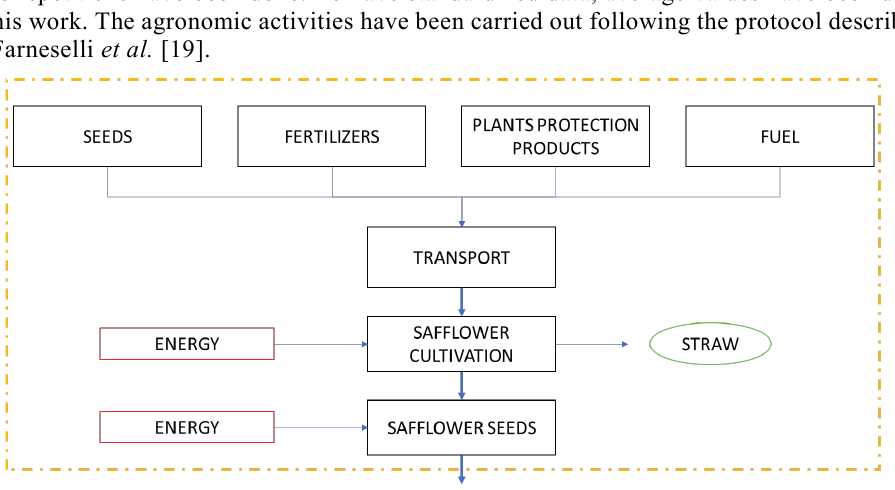
Fig. 1. Safflower LCI System